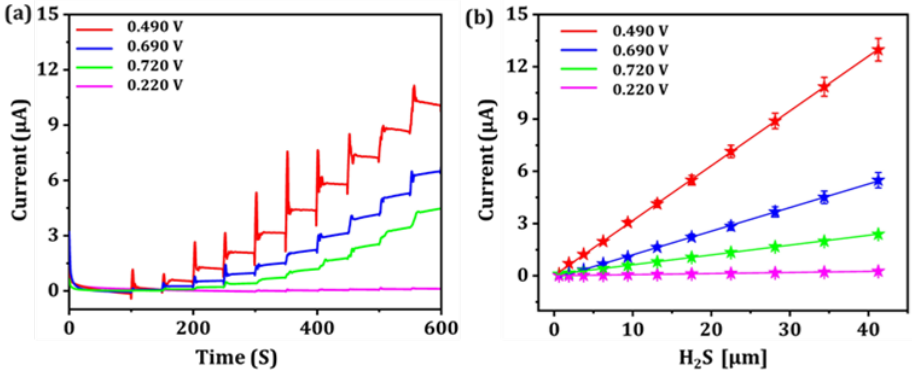
Figure 5. ( a ) Amperometry (i-t) response of the PtNi/SPE with different concentrations of sulfide (0.625 – 41.2 µM) in 0.05 M PB (pH 7.0) at various working potential ranges (0.49, 0.69, 0.72, and 0.22 V), ( b ) corresponding linear plot of I pa vs. [H 2 S] for different potentials.